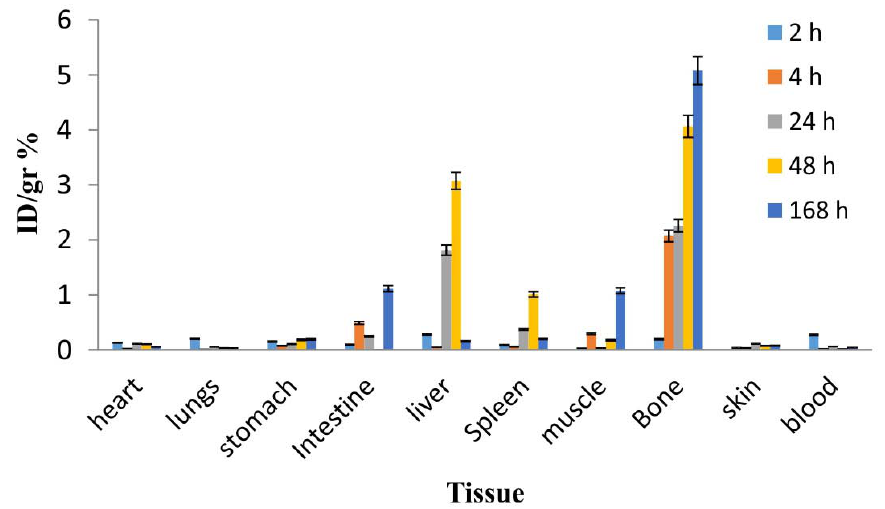
in wild-type rat tissues at 2, 4, 24, 48 and 168 h post injection 3